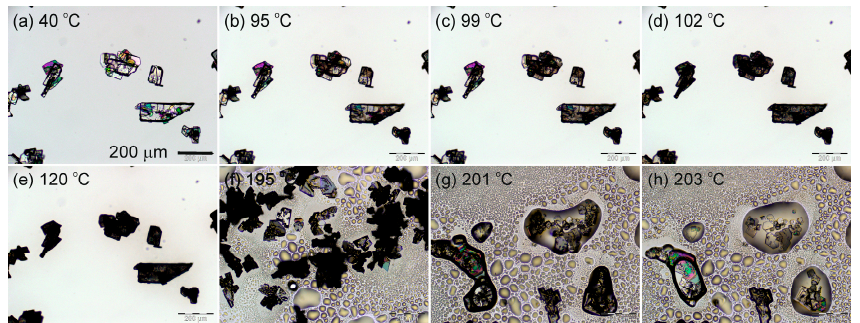
Figure 2. Microphotographs of 1-Hy1 . ( a – e ) Dehydration in the temperature range from 30 °C to 120 °C, ( f – h ) condensation, sublimation and melting of 1-I .